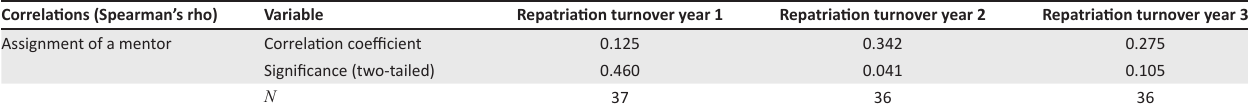
TABLE 10: Assigning a mentor and repatriation turnover rates. Correlations (Spearman’s rho)